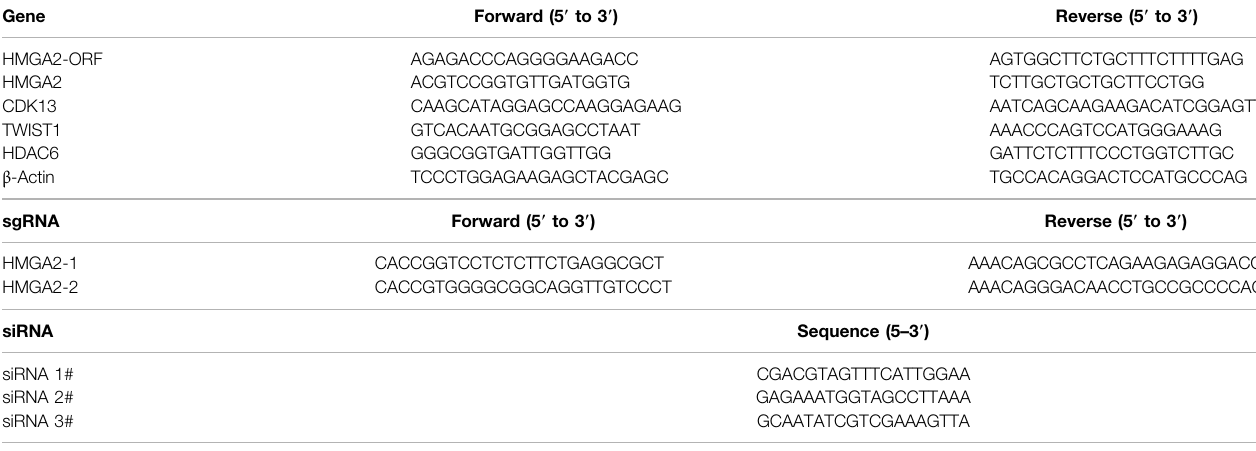
TABLE 1 | Sequences of primers, sgRNA, and siRNA used in the study.